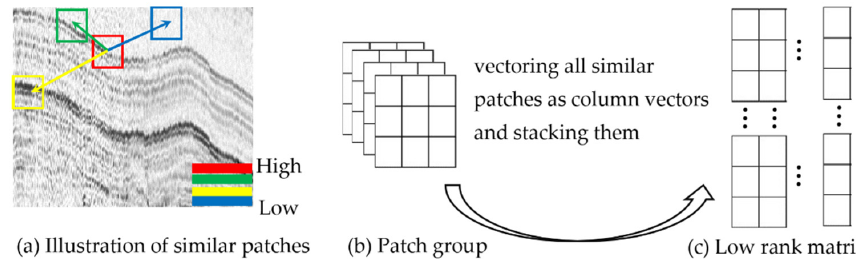
Figure 1. Illustration of patch searching and patch group construction. The different colored rectangles in ( a ) represent patches with different similarities, ( b ) denotes a patch group, and ( c ) is the constructed low-rank matrix.